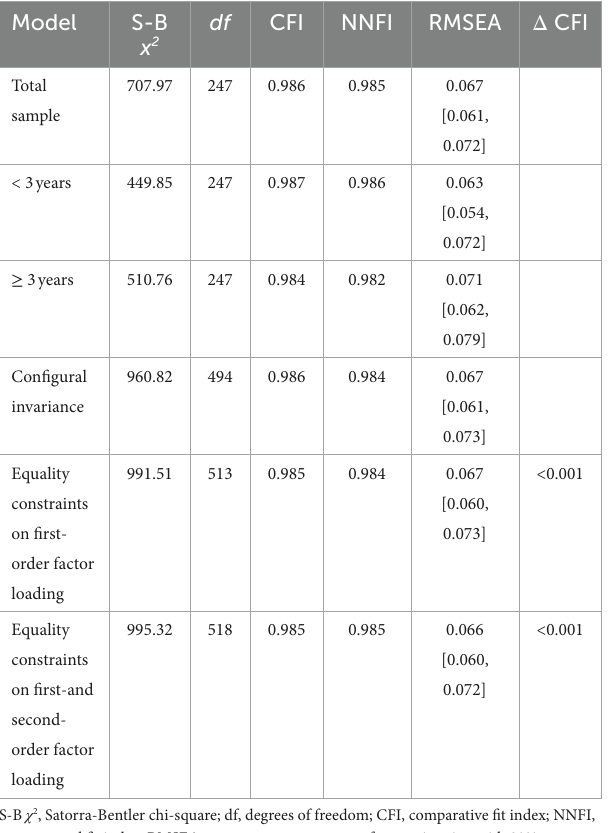
TABLE 5 Goodness-of-fit indices for the second-order factor model of the SBCS for the total sample ( N = 420) and by time from diagnosis (<3 years: N = 207; ≥ 3 years: N = 213), and tests of measurement invariance across time from